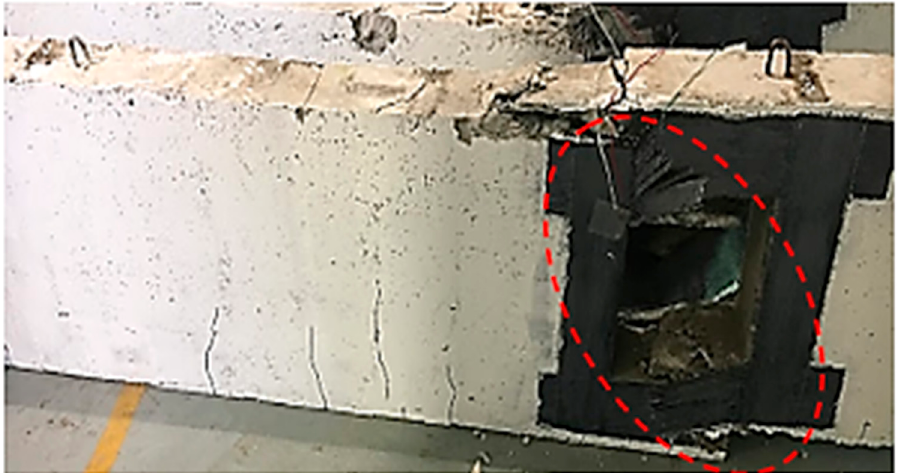
Figure 14. Failure mode and cracking pattern of deep beam B3c.